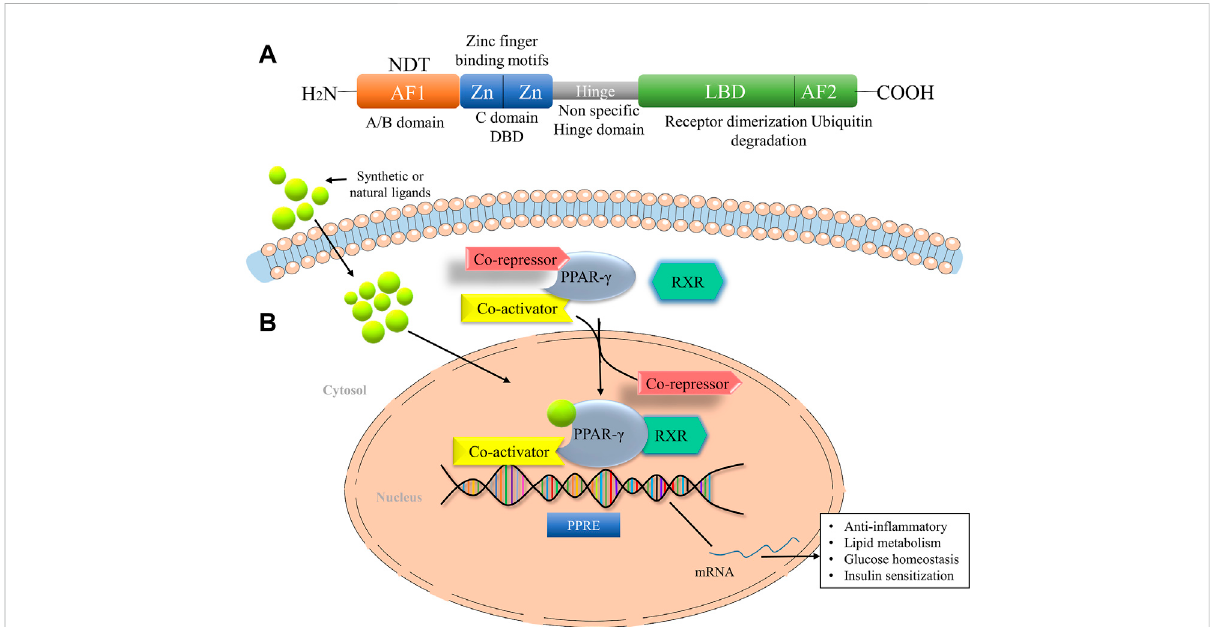
FIGURE 1 The domain structure of PPAR- γ and their mode of action. (A) Domain Structure of PPAR- γ facilitates the DNA binding at the DNA-binding domain (DBD). The ligand-binding domain (LBD) senses the agonists through the ligand-binding pocket. (B) PPAR- γ ligand binding to heterodimer consistofRXR,PPAR- γ ,andcorepressorpromotetheactivationofPPAR- γ transcriptionthroughbindingwithcoactivator.AF1,Activationfunction1, AF2, Activation function1, NTD, N-terminal domain,LBD, Ligandbindingdomain,RXR, Retinoid Xreceptor, NF- l B, Nuclear factor kappa-light- chain-enhancer of activated B cells, STAT, Signal transducer and activator of